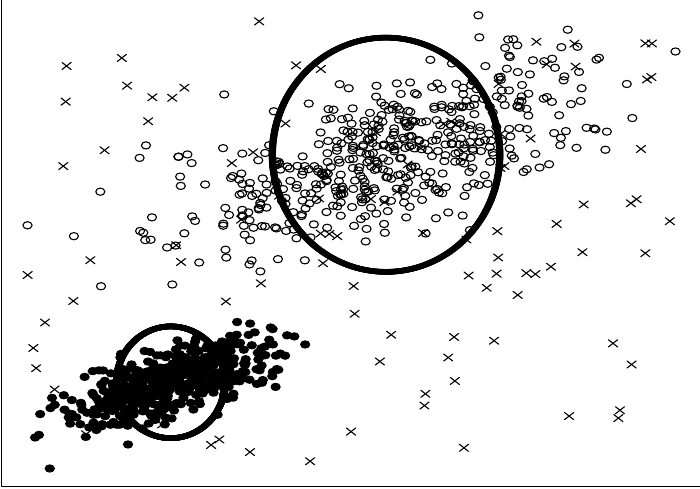
Figure 6. An example. Bold circles are effective circles for the two clusters respectively. Those little circles are original data points, and crosses are seeded points with uniform distribution law. This dataset has been optimally clustered, and the points belonging to the left-bottom cluster have been marked by solid